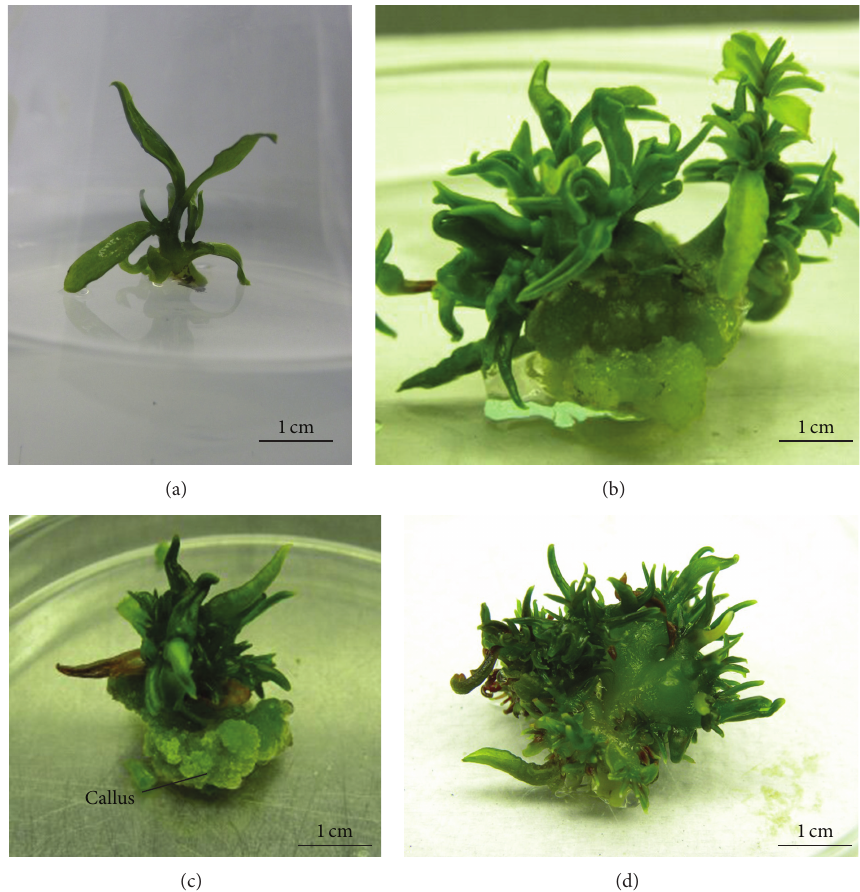
Figure 5: Undesirable influence of different concentrations of TDZ (mg/L) in combination with GA 3 (mg/L) on shoot multiplication, (a)